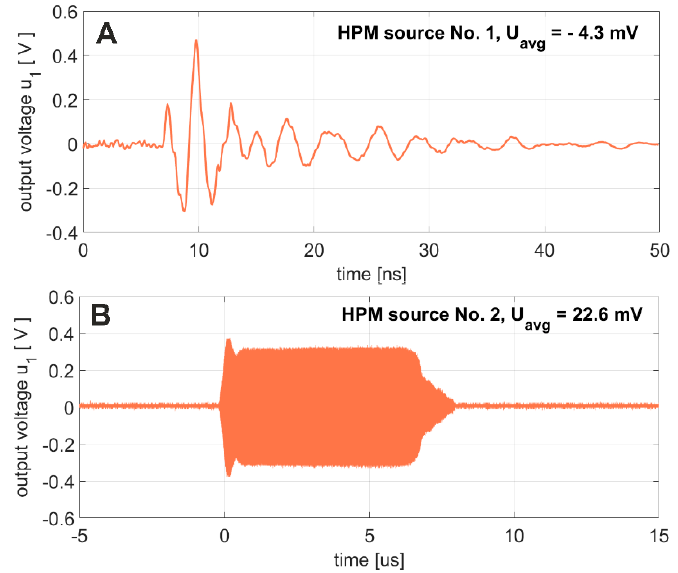
Figure 4. Voltage waveforms recorded at the output of the analogue section of the measurement chain, corresponding to two different HPM sources: ( A ) Marx generator; ( B ) magnetron generator. Each of those signals had a determined mean value U avg throughout the entire record- ing interval. The obtained values were − 4.4 mV and 22.6 mV, respectively. The non-zero mean value indicated the possibility of an integral waveform trend, which is illustrated in Figure 5.